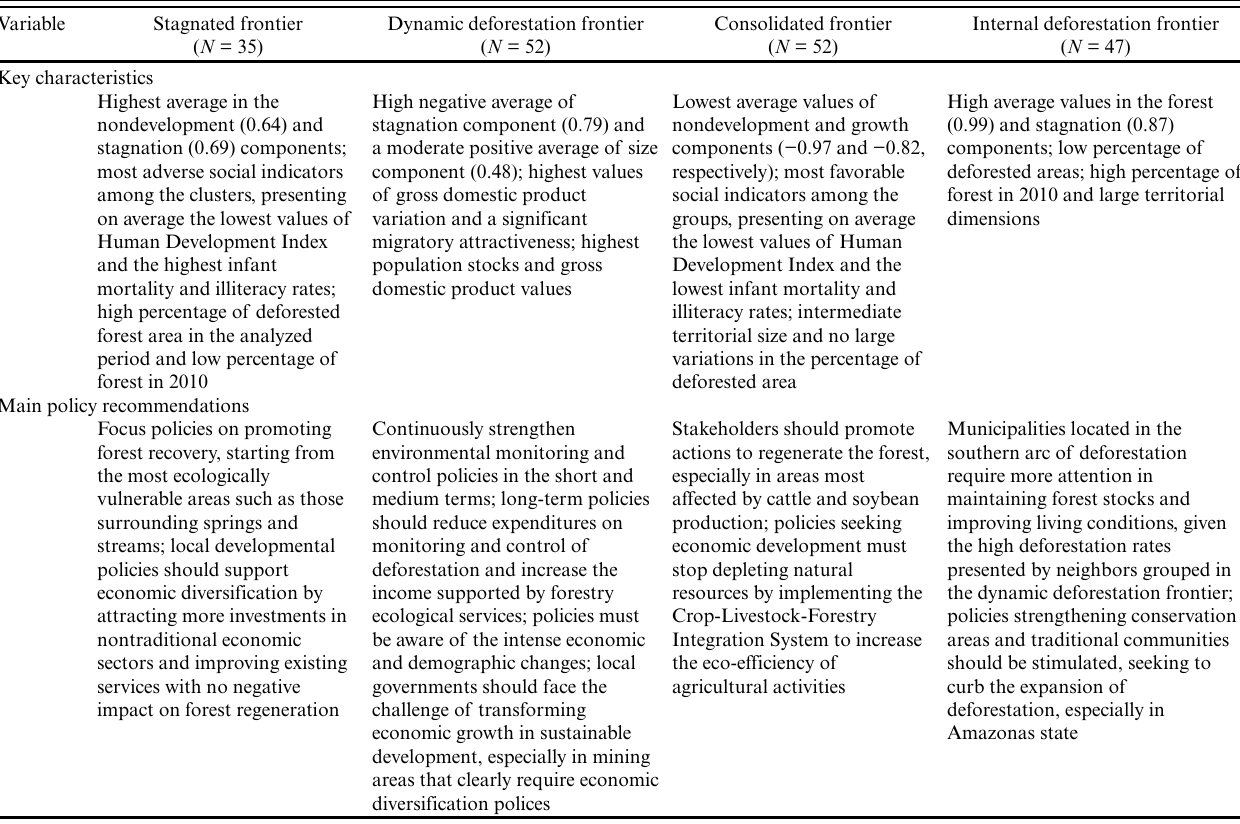
Table 5. Key characteristics of the four clusters and main policy recommendations.